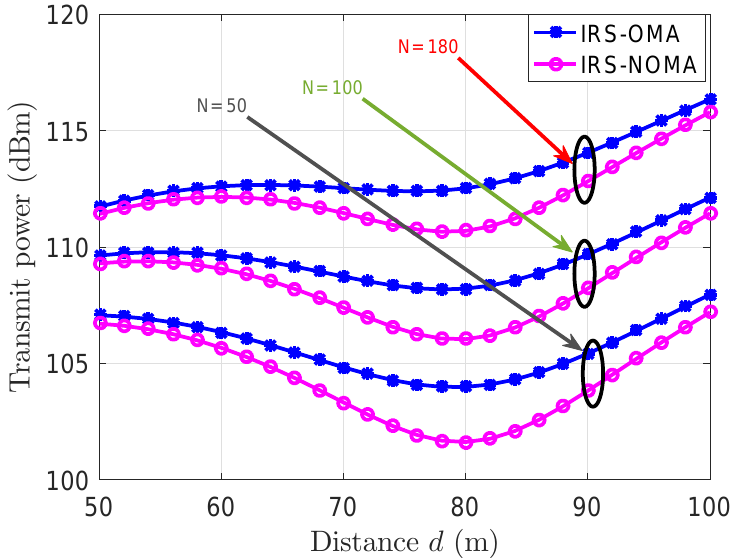
Figure 4. The required transmission power by IRS-NOMA and IRS-OMA for different destination locations to achieve a target rate of 50